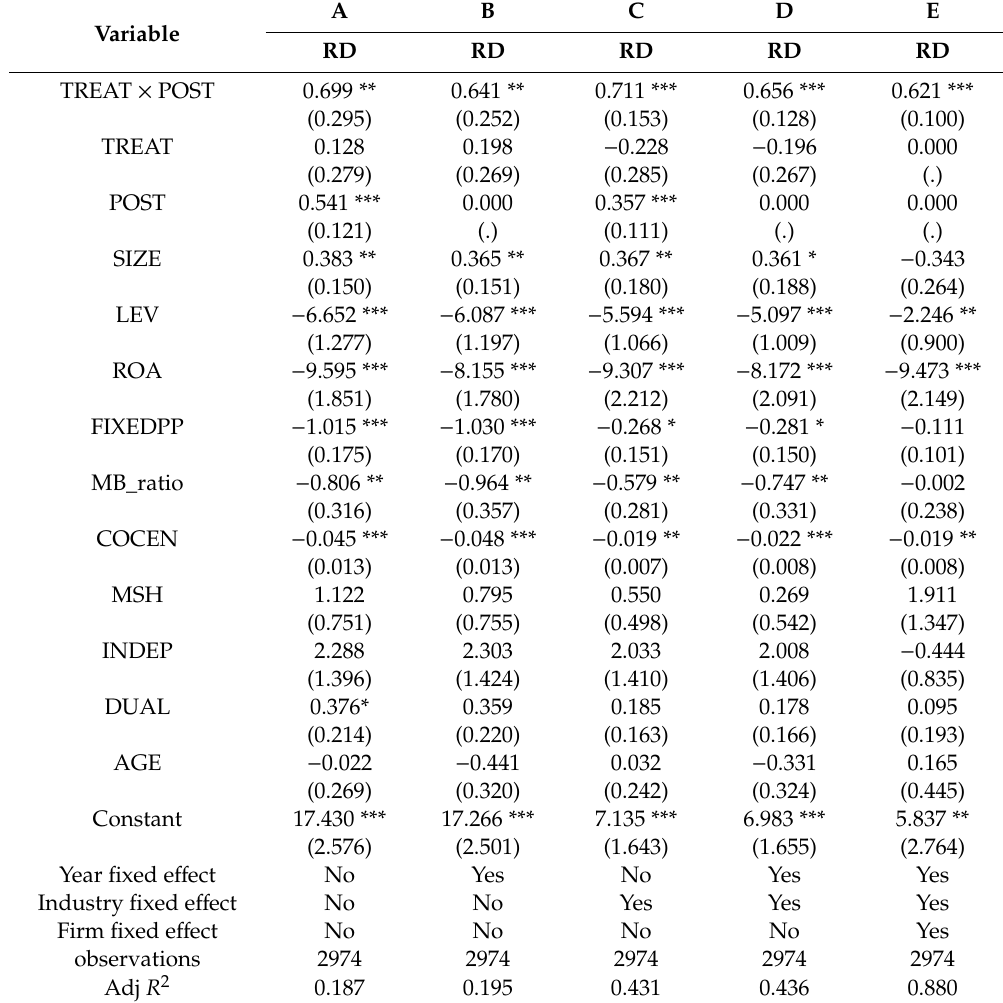
Table 3. The results of the impact of CCETP on the R&D investment of publicly listed private